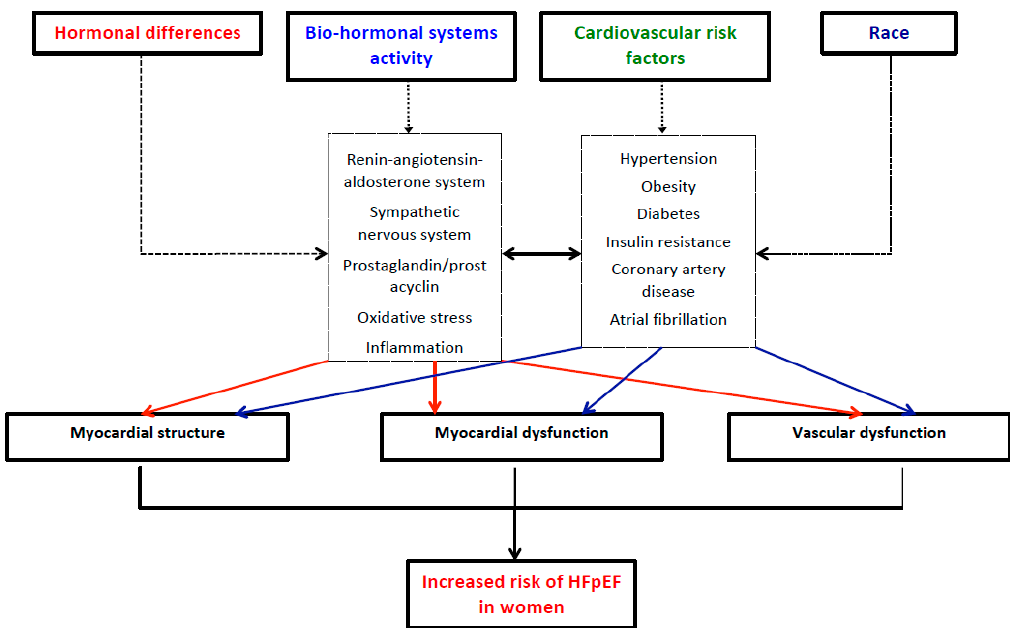
Figure 1. Sex differences in HFpEF development.